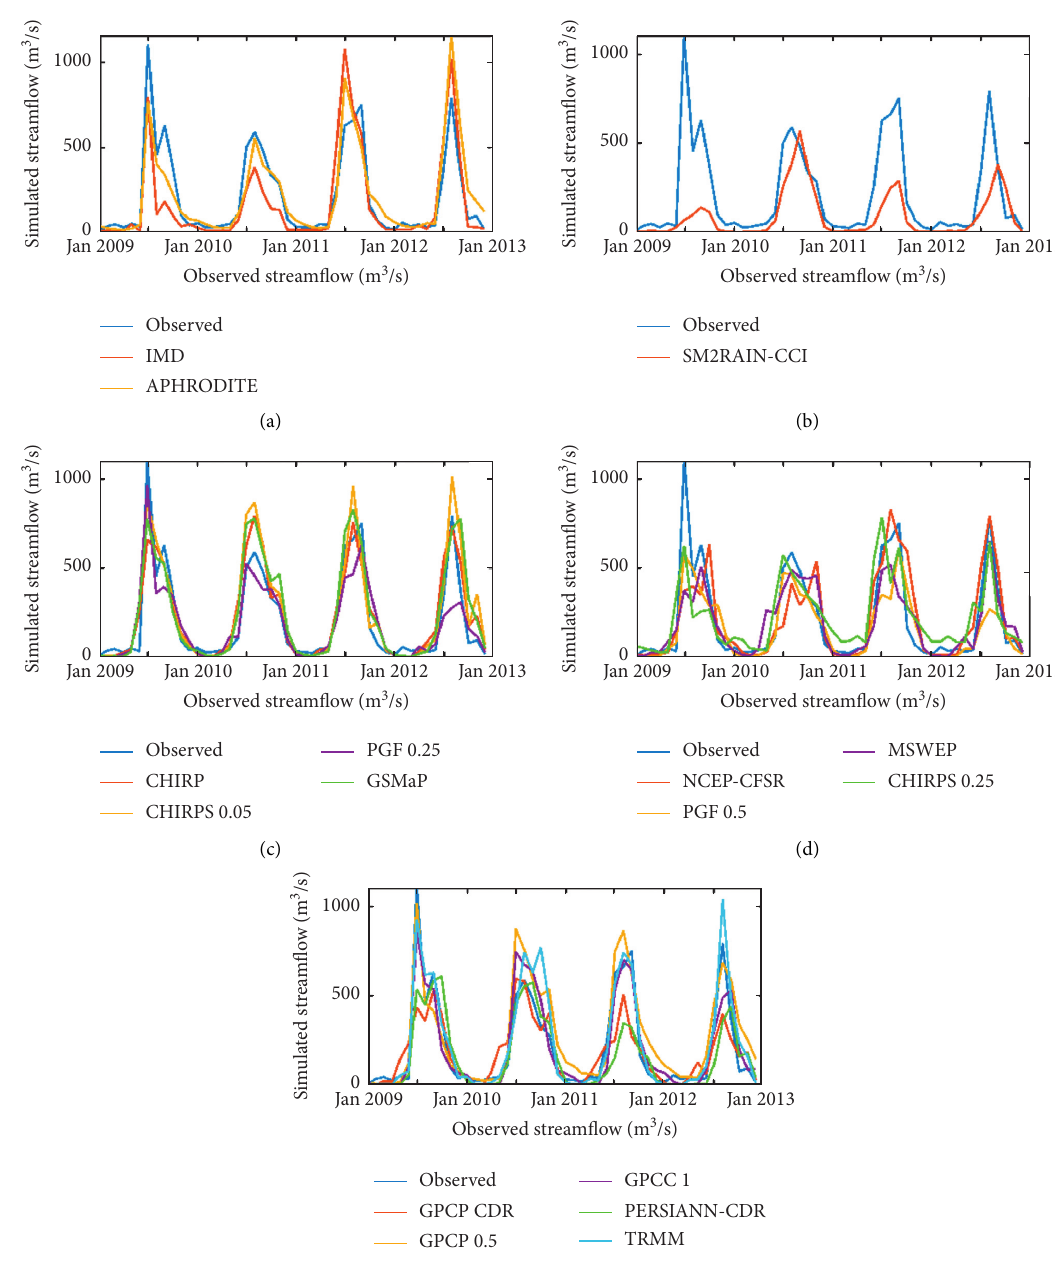
Figure 10: Monthly time series of simulated and observed runoff for observed and (a) gauge-based, (b) satellite-only, ((c) & (d)) reanalysis, and (e) gauge-adjusted datasets during the validation